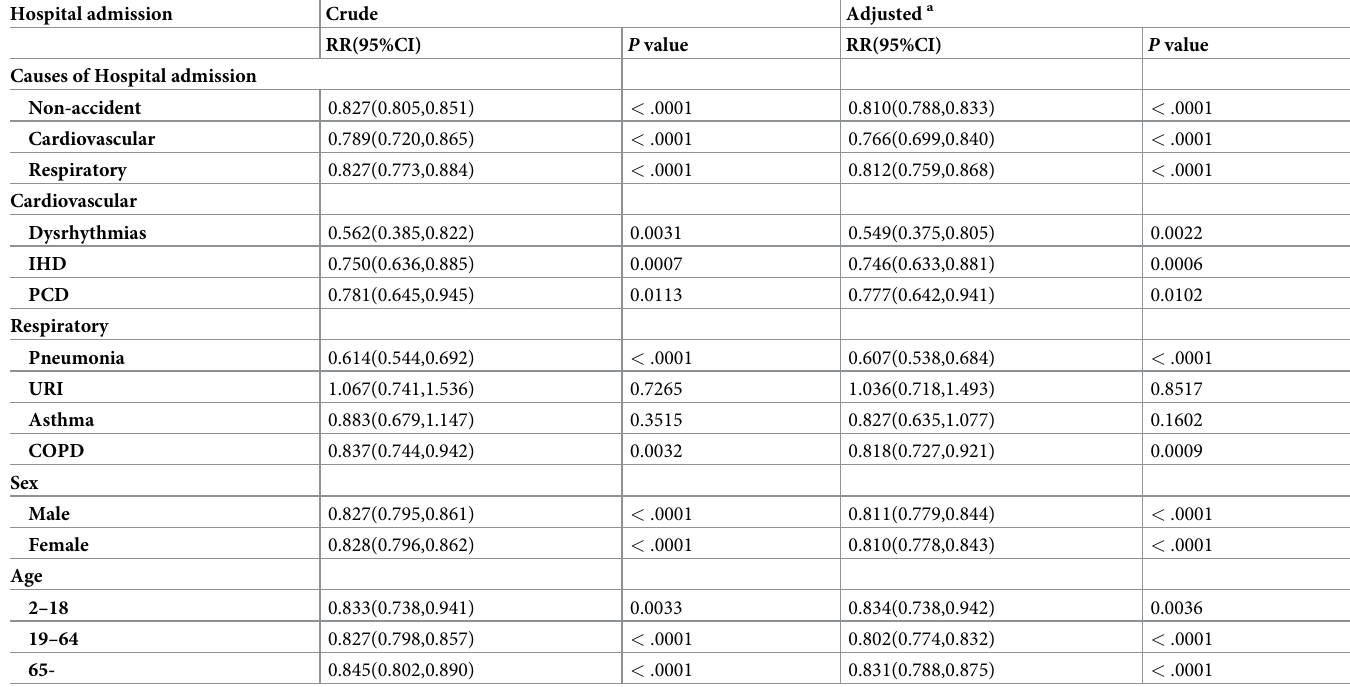
Table 2. Univariate and adjusted relative risk (RR) of hospital admissions during the 2010 Asian Games compared with the baseline